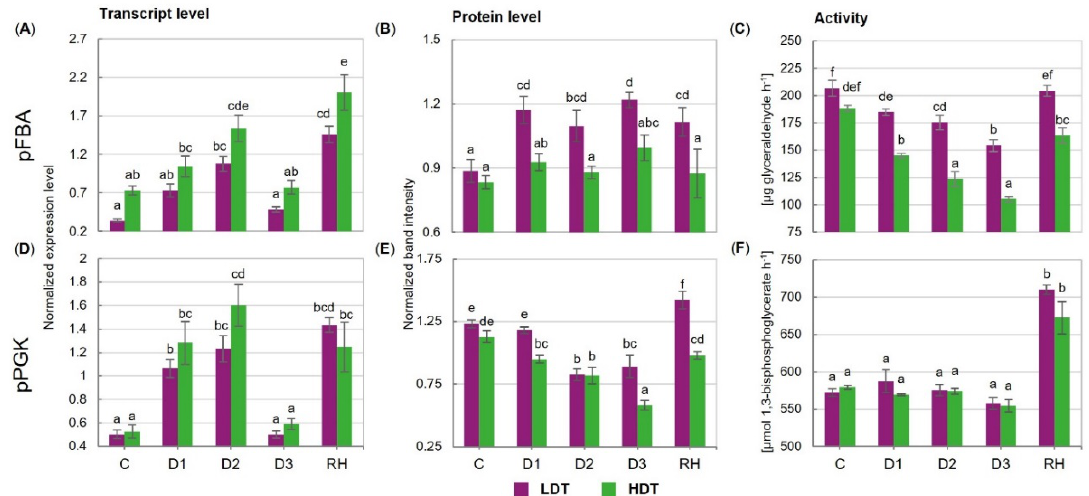
Figure 3. ( A – C ) Expression and activity of plastid fructose-1,6-bisphosphate aldolase (pFBA) and ( D – F ) plastid phosphoglycerate kinase (pPGK) in two L. multiflorum / F. arundinacea introgression forms (low- and high-drought tolerant—LDT and HDT, respectively) before stress treatment (C), on the 3rd (D1), 6th (D2), and 10th (D3) day of water deficit and 10 days after re-hydration (RH). The transcript accumulation levels of actin and ubiquitin were used as references. Error bars represent the standard errors. Homogeneous groups are denoted by the same letter according to Fisher’s LSD test ( p = 0.01).